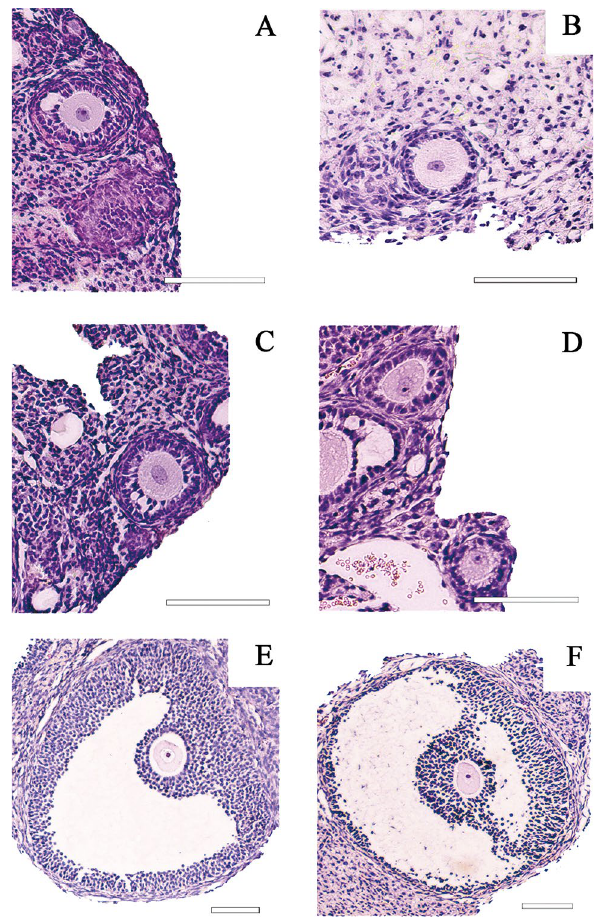
Figure 2. Morphologically normal follicles found in mice ovarian tissue, stained with Hematoxylin/Eosin. Fresh non-transplanted group ( A ), Fresh transplanted group ( B , E ), Cryopreserved non-transplanted group ( C ) and Cryopreserved transplanted group ( D , F ). Scale = 100 µm.